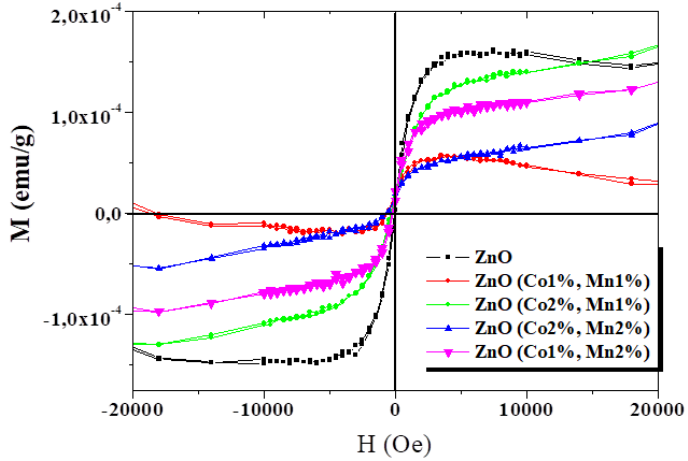
Figure 5. Magnetization as a function of magnetic field at room temperature for the ZnO and (Co, Mn) co-doped ZnO samples.